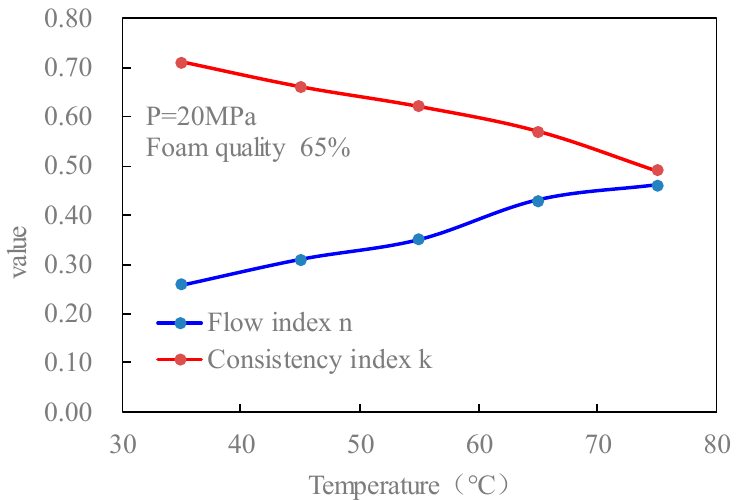
Figure 16. Variation curves of flow index n and consistency index k with temperature (foamed).